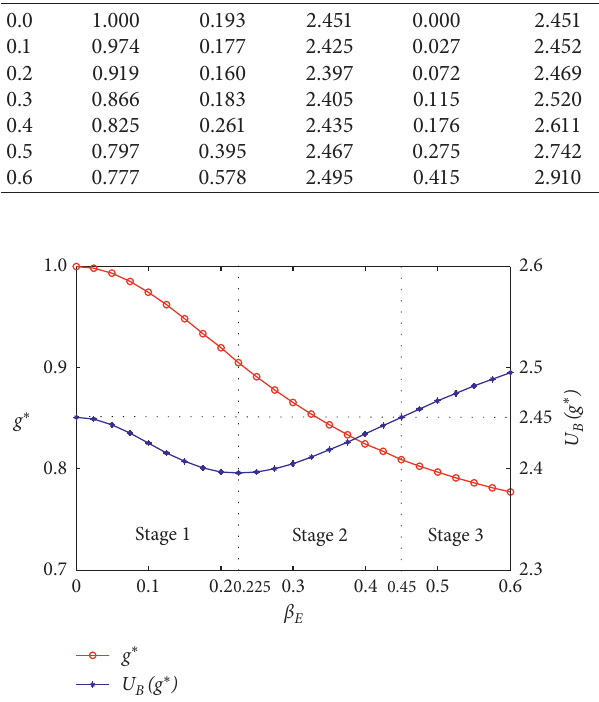
Figure 2: Changes of g ∗ and U